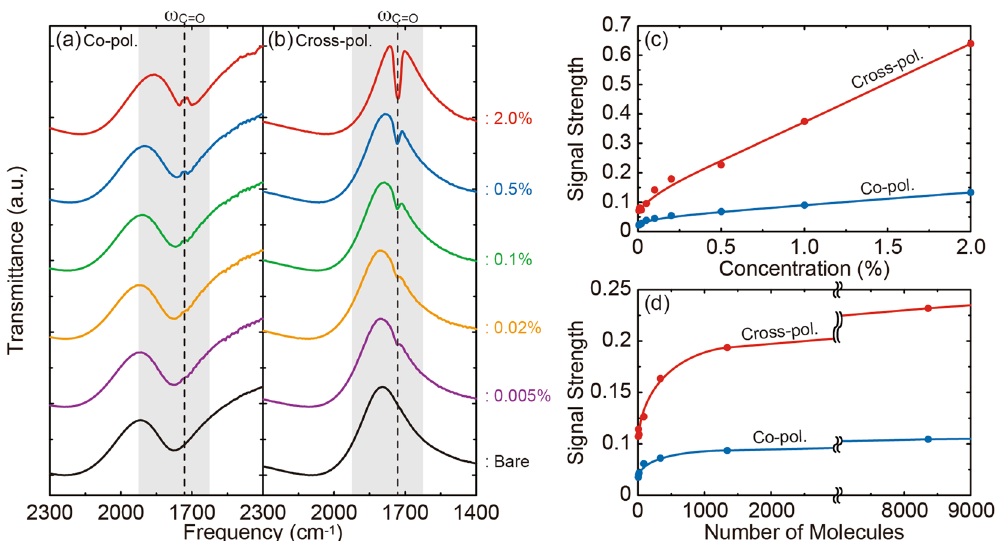
Figure 5. Comparison of the measured signal strengths between the co- and cross-polarizations. ( a ) Co- and ( b ) cross-polarized transmission spectra of a PMMA thin film on the metamaterials by progressively decreasing the solid content of PMMA solution. ( c ) Extracted signal strengths as the function of the PMMA concentration, and ( d ) the same ones as the function of the number of PMMA molecules within the unit